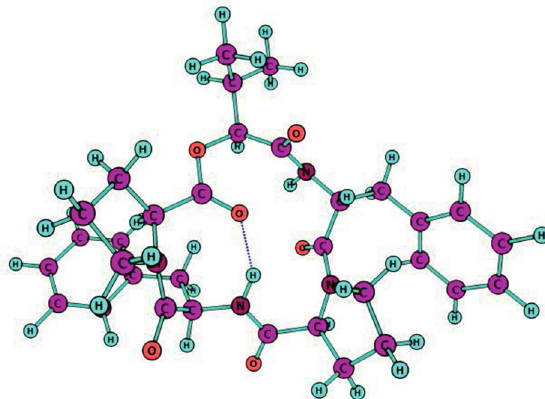
Figure 3: Molecular structure of alternaramide showing the in- ternal H-bond.